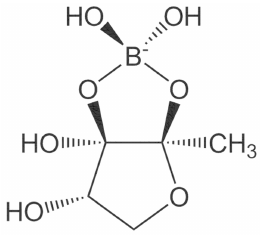
Figure 5. Iron structure.